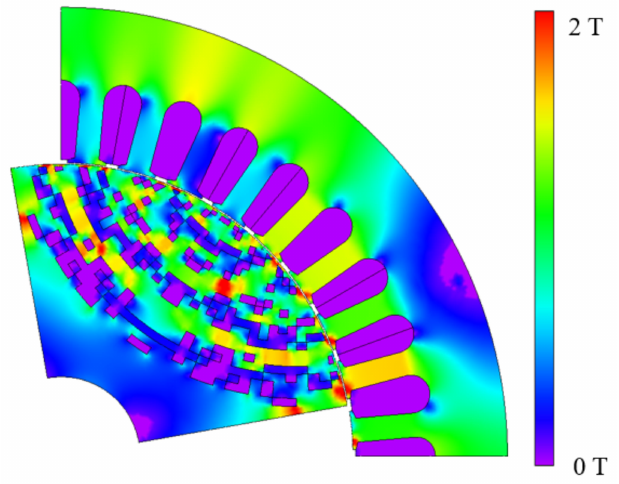
Figure 8. Shape and magnetic flux density of GA result